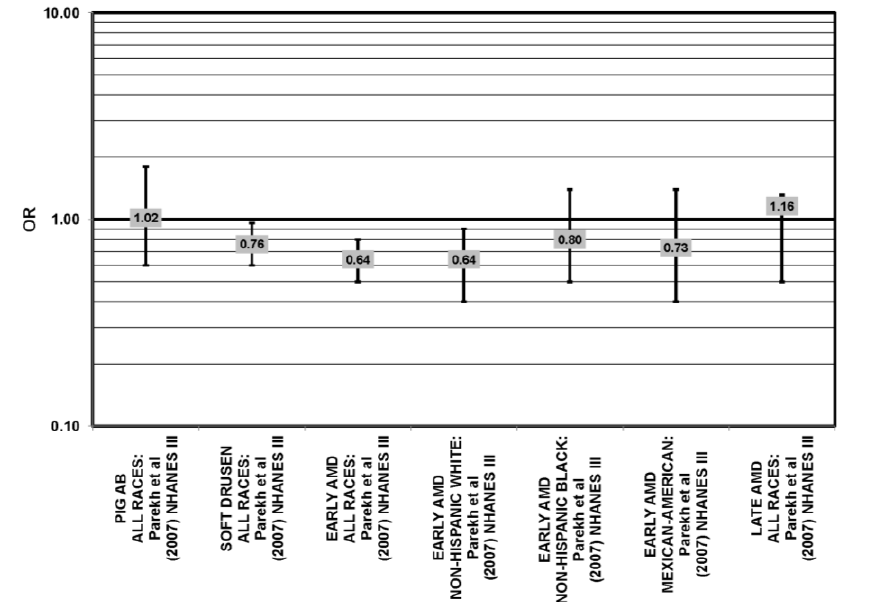
Figure 40. Odds ratio for early AMD, indicators of early AMD (PIG AB, SOFT DRUSEN) or advanced AMD; high vs. low serum levels of vitamin D: retrospective studies.